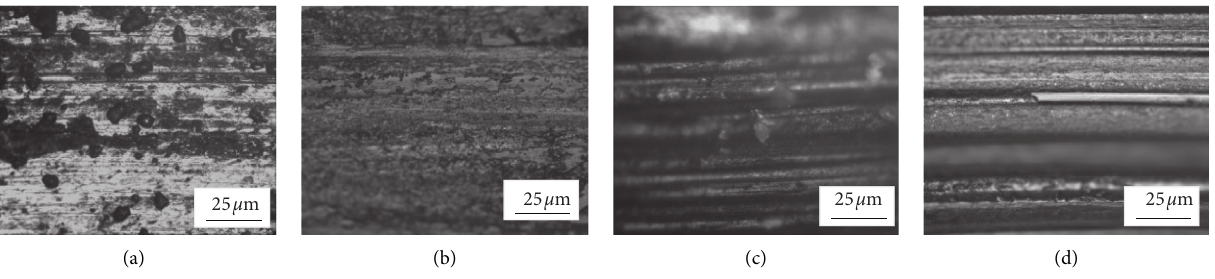
Figure 19: Worn morphologies of samples at 700 ° C: (a) H13 steel; (b) S0 coating; (c) S1 coating; (d) S2 coating.